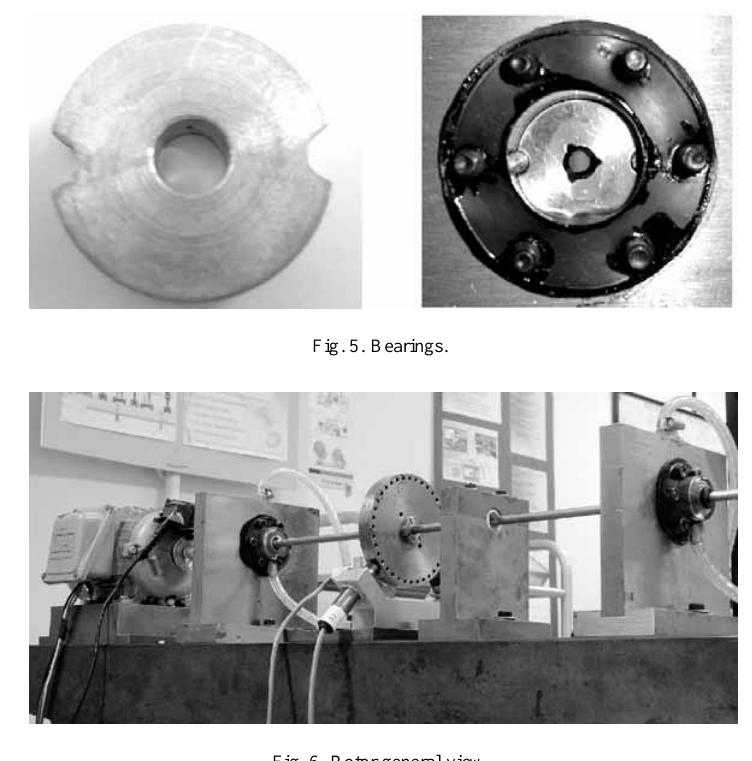
Fig. 6. Rotor general